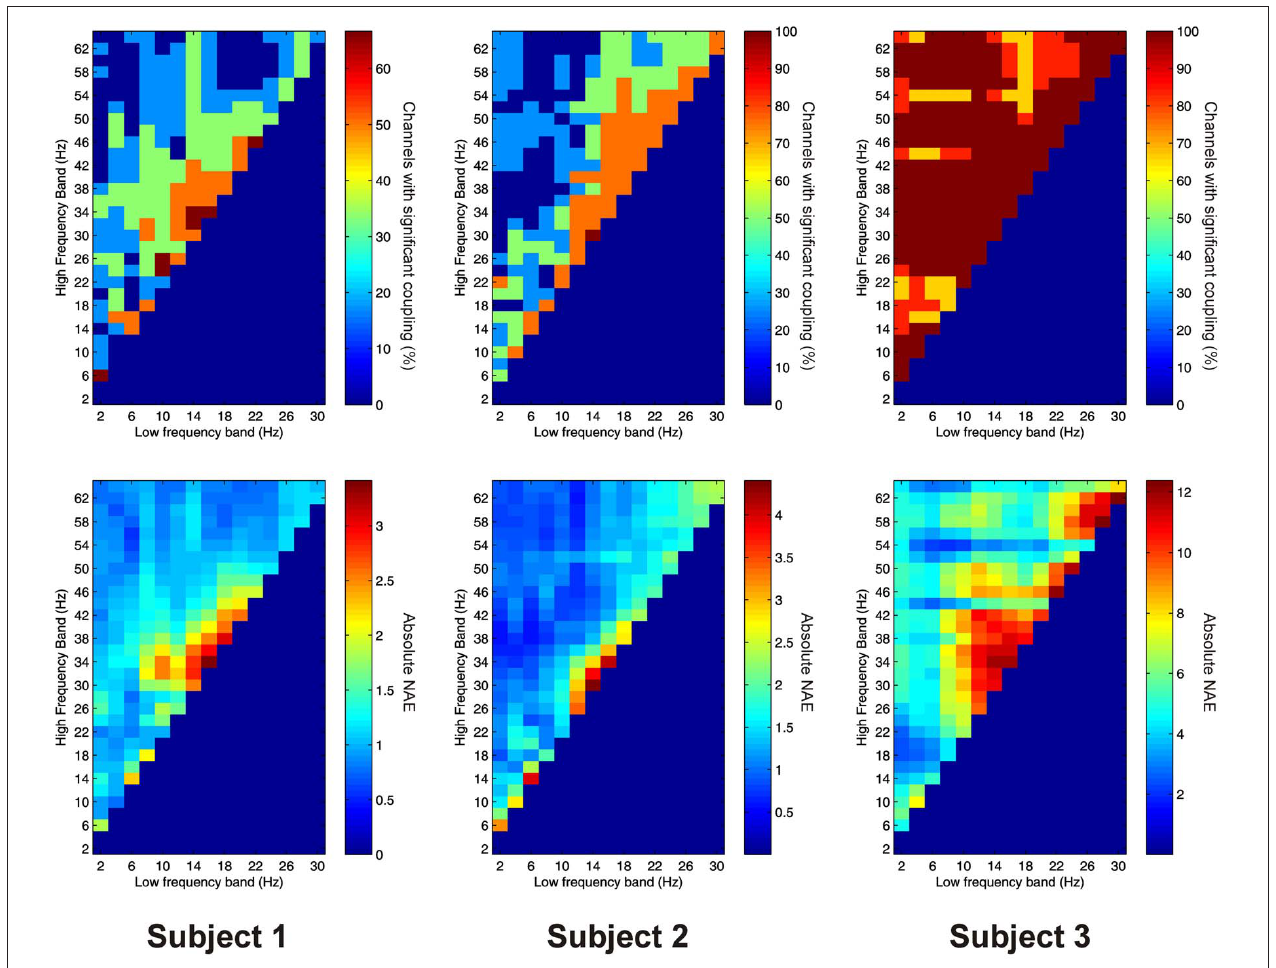
FIGURE 3 | Top row: Proportion of channels showing significant local AAC in the thalamus (Subject 1 left, Subject 2 middle, Subject 3 right). Bottom row: Mean strength of AAC (assessed